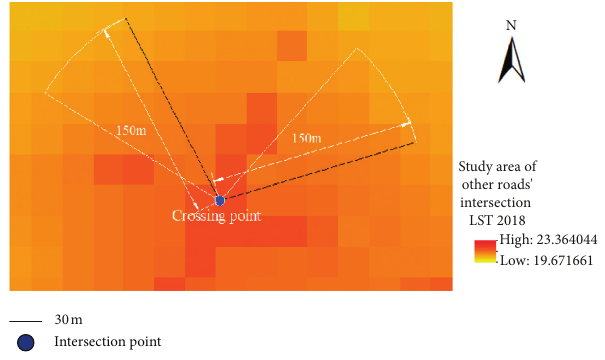
Figure 14: LST spread diagram of typical